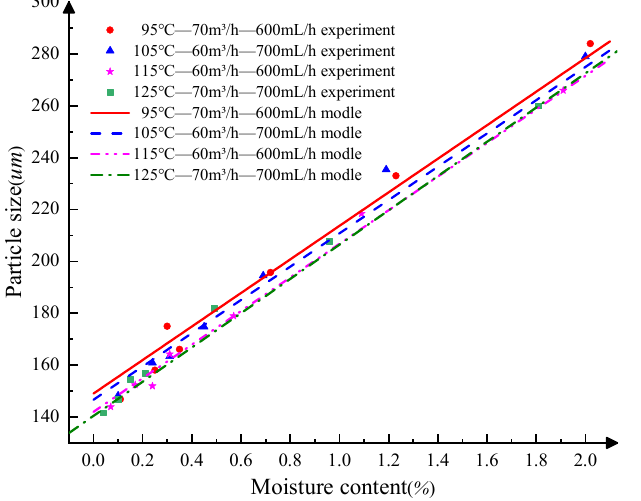
Figure 14. Comparison between model curve and experimental value of yeast particle size changing with moisture content.